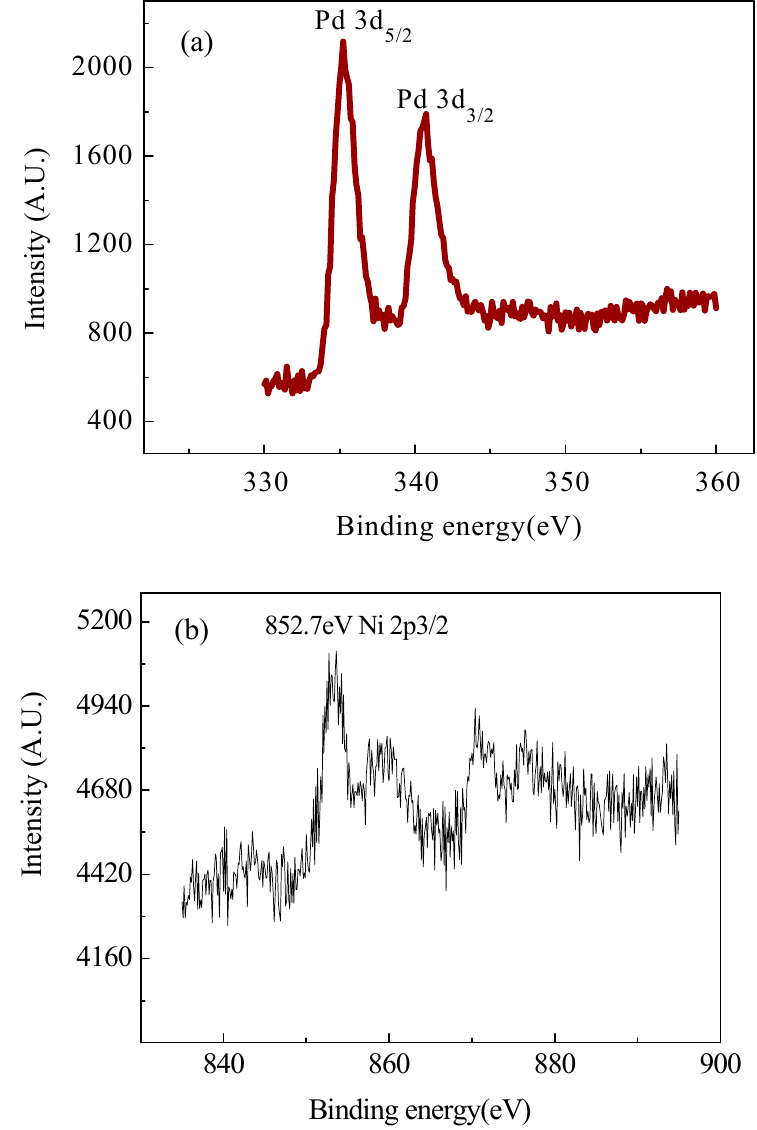
Figure 4. XPS of Pd/Ni electrode: ( a ) Pd 3d core-level, ( b ) Ni 2P core-level.